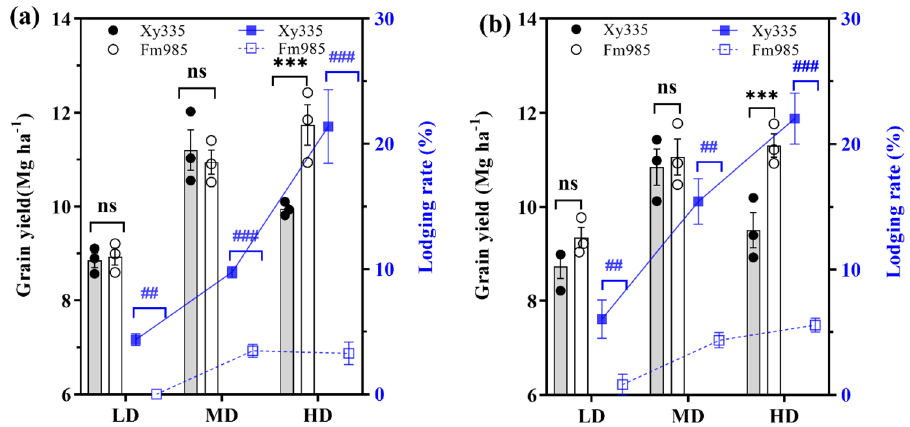
Figure 1. Comparison of maize grain yield, and lodging rate in 2018 ( a ) and 2019 ( b ) at varied planting densities. LD, MD, and HD represent low, medium, and high planting densities, respectively. Bars denote the SE of the mean (n = 3). ns, not significant ( P > 0.05), ** and *** indicate differences of grain yield significant at 0.01and 0.001levels, # and ### indicate differences of lodging rate significant at 0.01and